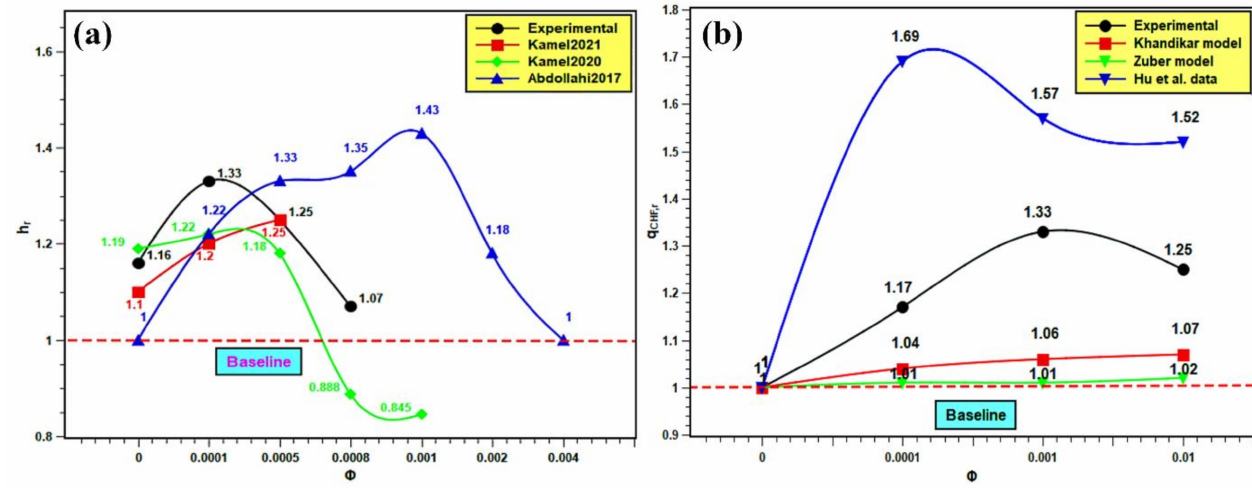
Figure 17. Comparison with published literature: ( a ) for PBHTC enhancement and ( b ) for CHF